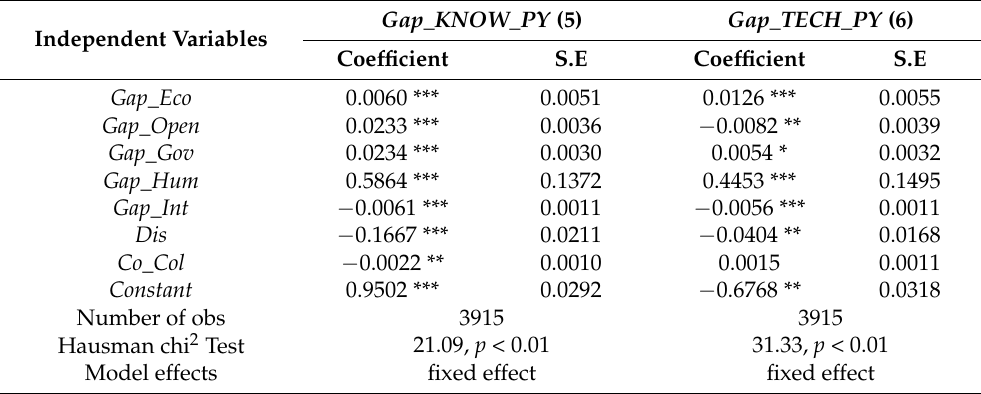
Table 3. Econometric results: The impact of Co_Col on the interregional gaps of knowledge produc- tivity and technology transfer